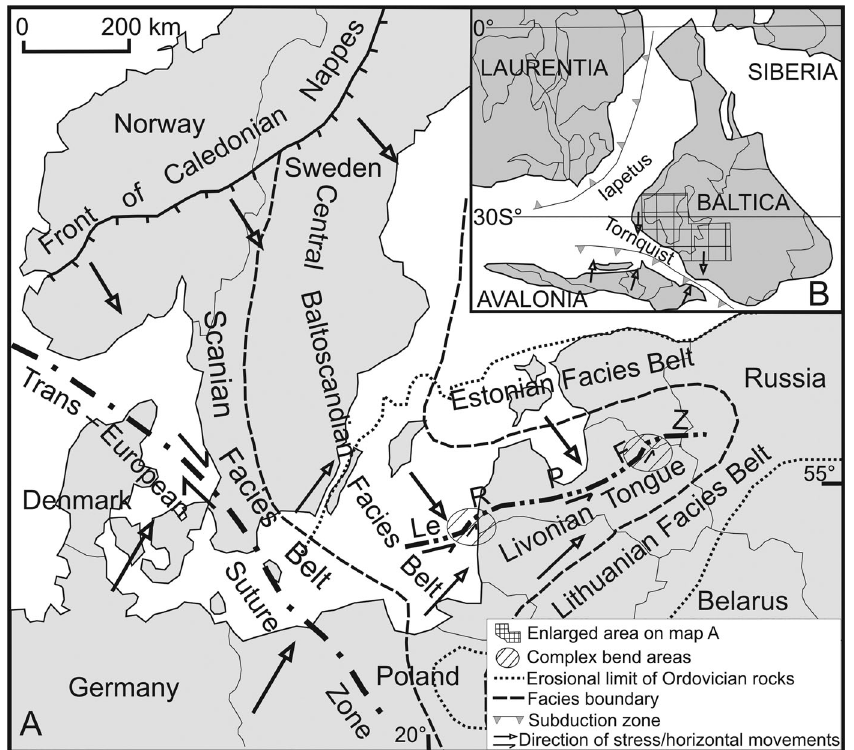
Fig. 13. ( A ) General facies zonation with the Livonian Tongue of the Baltoscandian (Ordovician) Basin (modified after Kaljo et al. 2007) with ( B ) Late Ordovician (Katian, at 450 Ma) plate tectonic relations of the Baltica–Avalonia–Laurentia continents (modified after Torsvik & Cocks 2013) and suggested directions of palaeostresses with horizontal fault